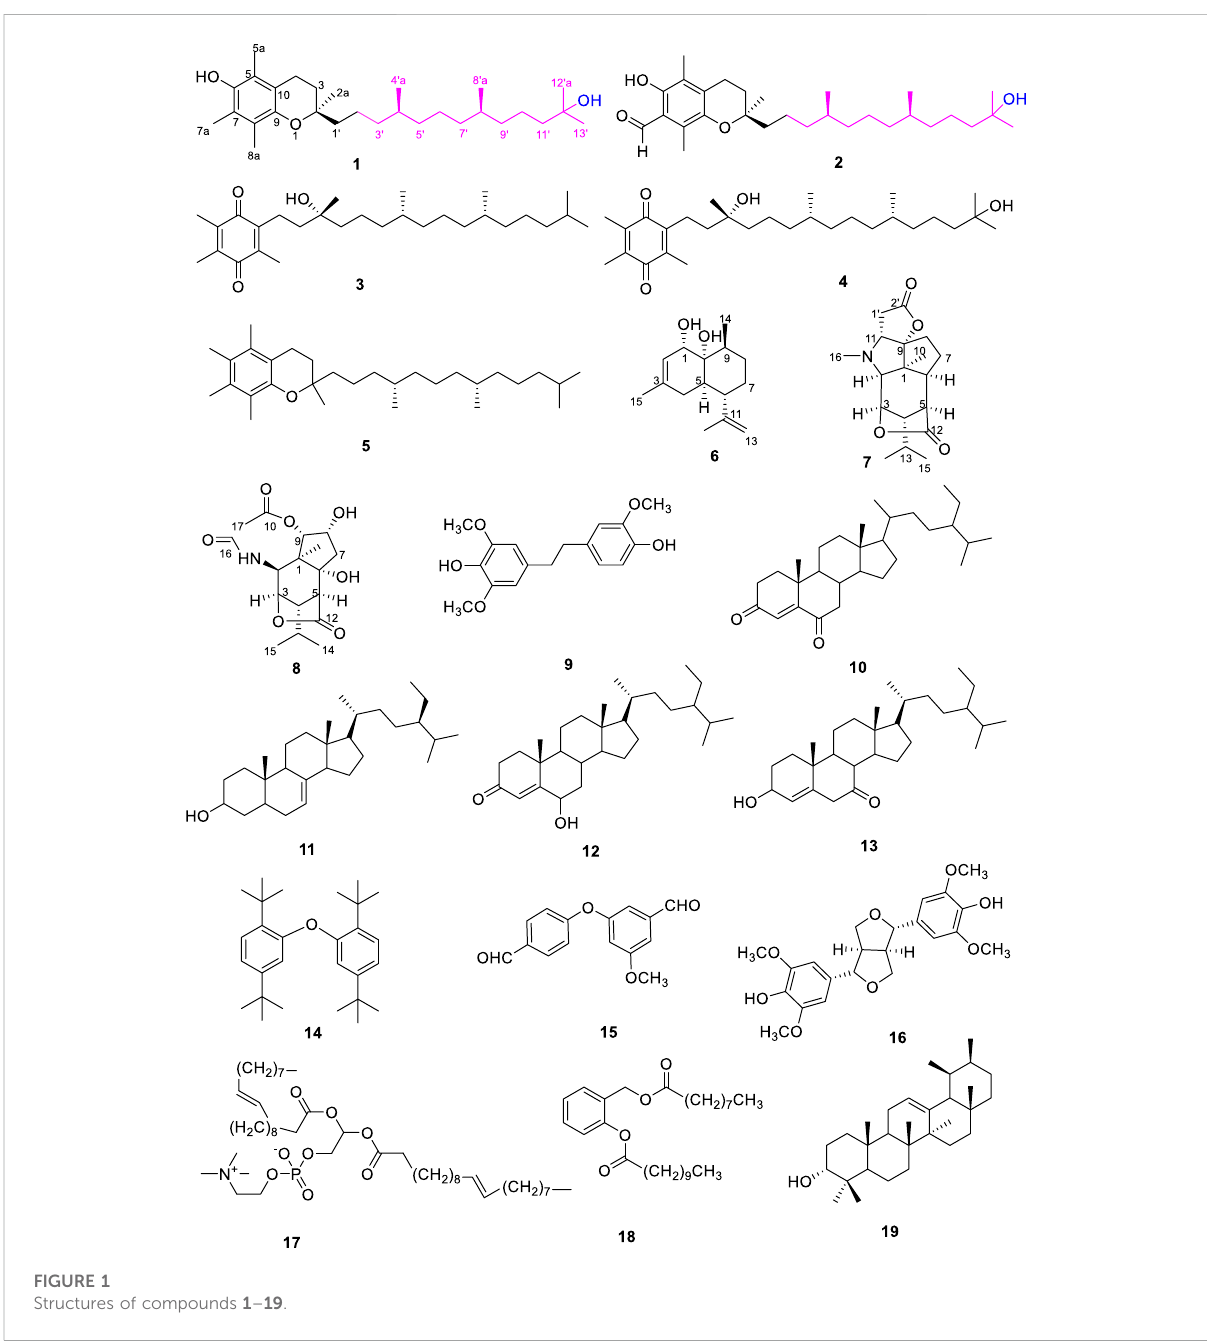
FIGURE 1 Structures of compounds 1 – 19